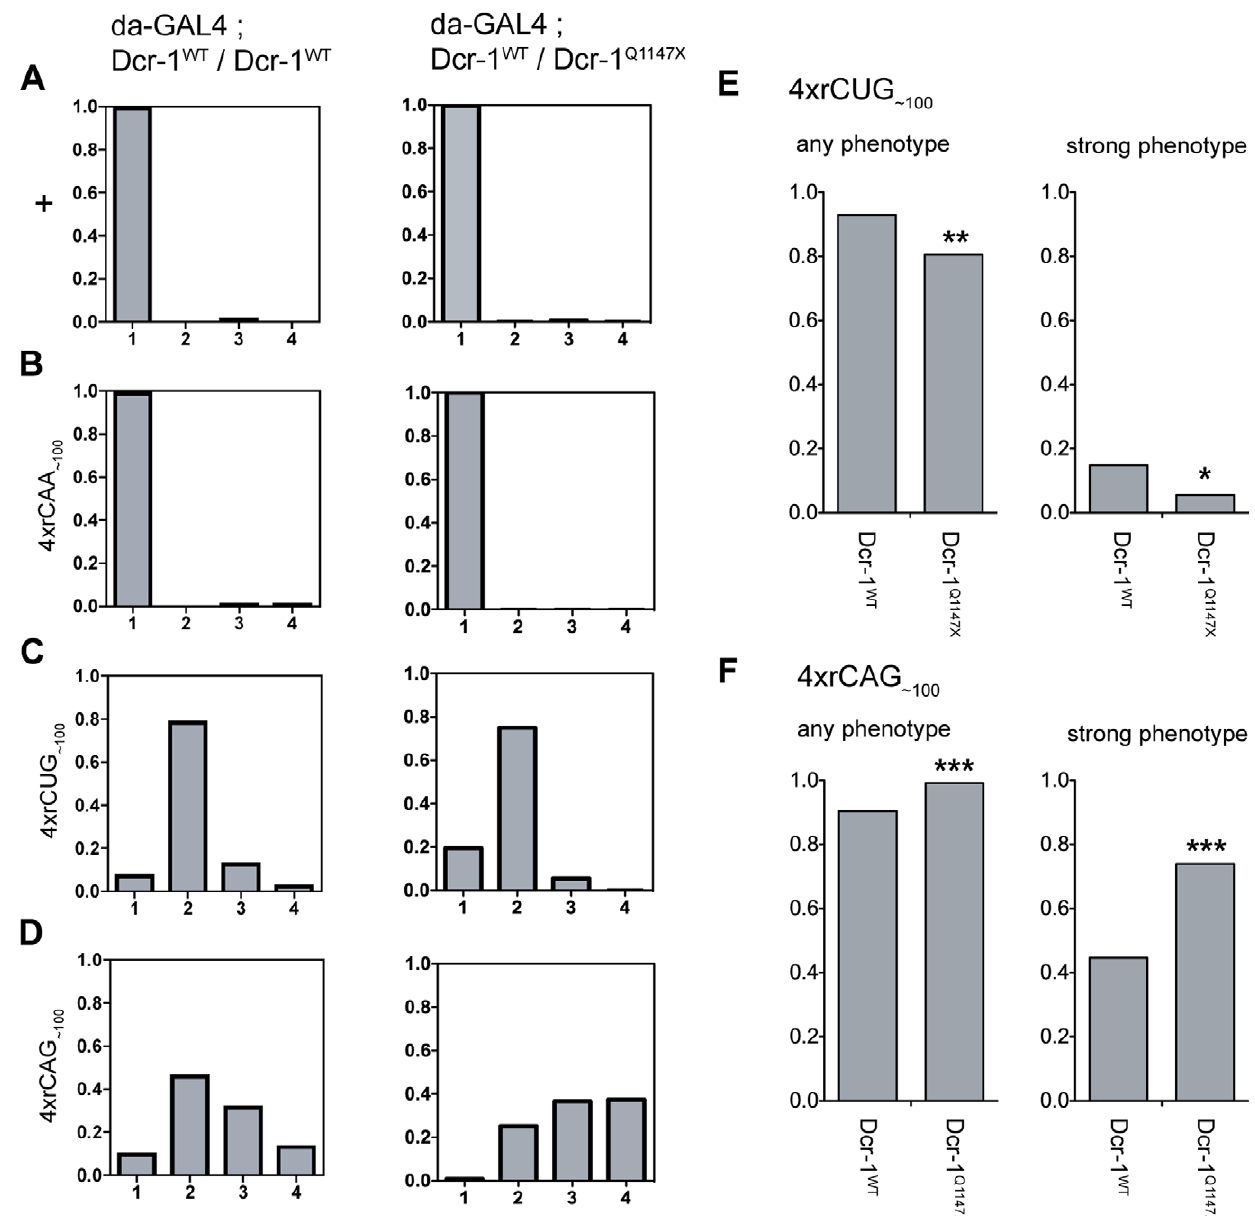
Figure 4. Reduced Dicer-1 processing can have opposing effects on CUG or CAG RNA-mediated tergite phenotypes. A-D , Proportion of progeny within each phenotype category for expression with da-GAL4 alone (left column), or in the presence of the Dcr-1 Q1147X mutant allele such that Dcr-1 levels are reduced (right column). A , wildtype control, B , 4xrCAA , 100 [line 1], C , 4xrCUG , 100 [line 1], D , 4xrCAG , 100 [line 2]. E, F , Total proportion for each genotype that shows any phenotype (‘any phenotype’ - category 2, 3 and 4) and the proportion with a strong phenotype (‘strong phenotype’ – category 3 and 4). E , 4xrCUG , 100 [line 1] shows a suppression for both measures. F , 4xrCAG , 100 [line 2] shows an enhancement for both measures. Comparisons were made between the populations using Fisher’s exact test, with significant results indicated above the proportion, where *p , 0.05, **p , 0.01 and ***p , 0.001.